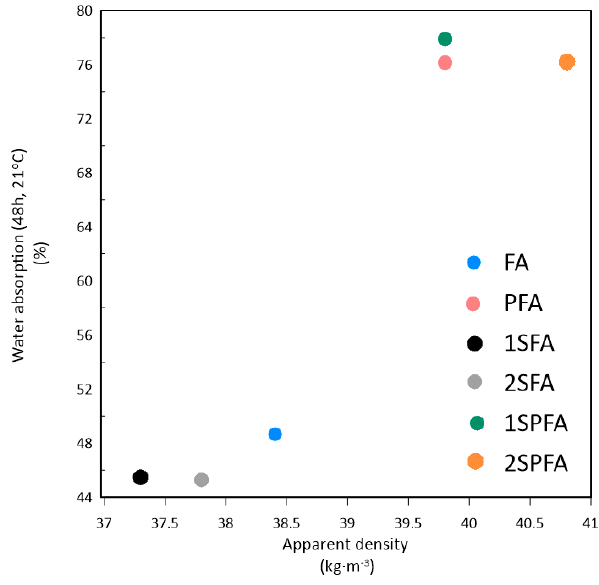
Figure 5. Dependence between apparent density and water absorption of samples. The friability results for polyurethane foams with modified fillers are depicted in Figure 6.